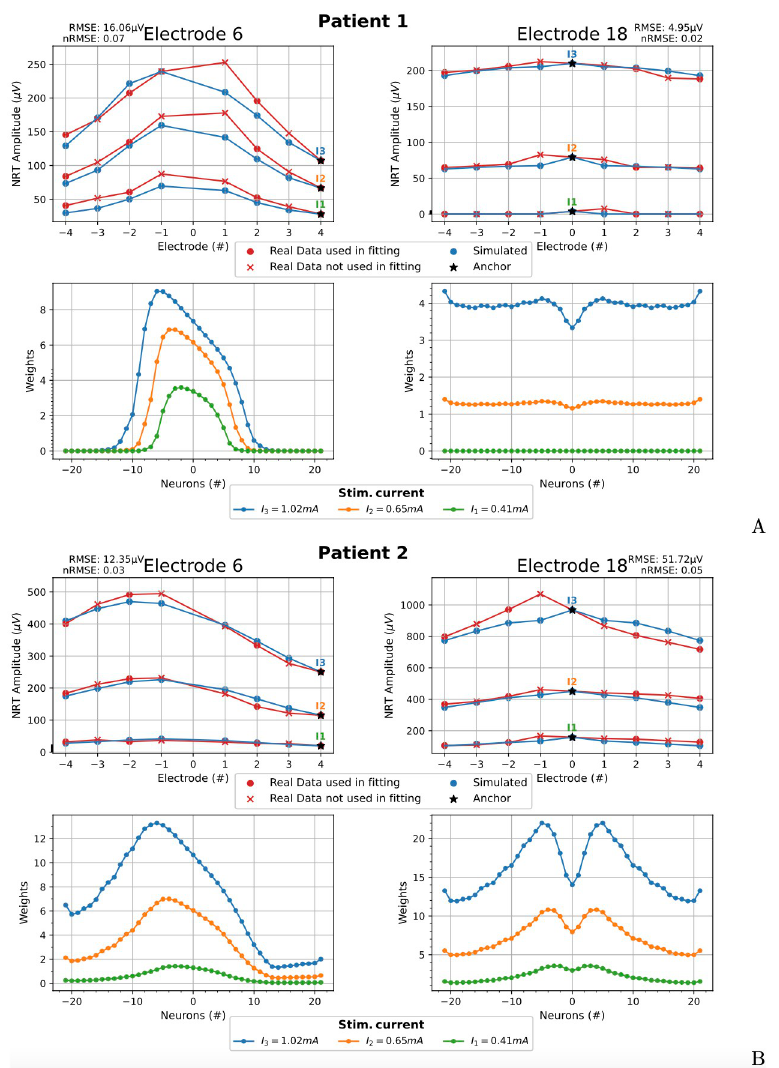
Fig 13. Comparison between real and simulated NRT amplitudes with incomplete training dataset. Resulting NRT amplitudes using only the values from electrodes ± 2 and ± 4 as training data for the optimization. The anchor electrode is the optimal in both cases. RMSE and normalized RMSE (nRMSE) values are